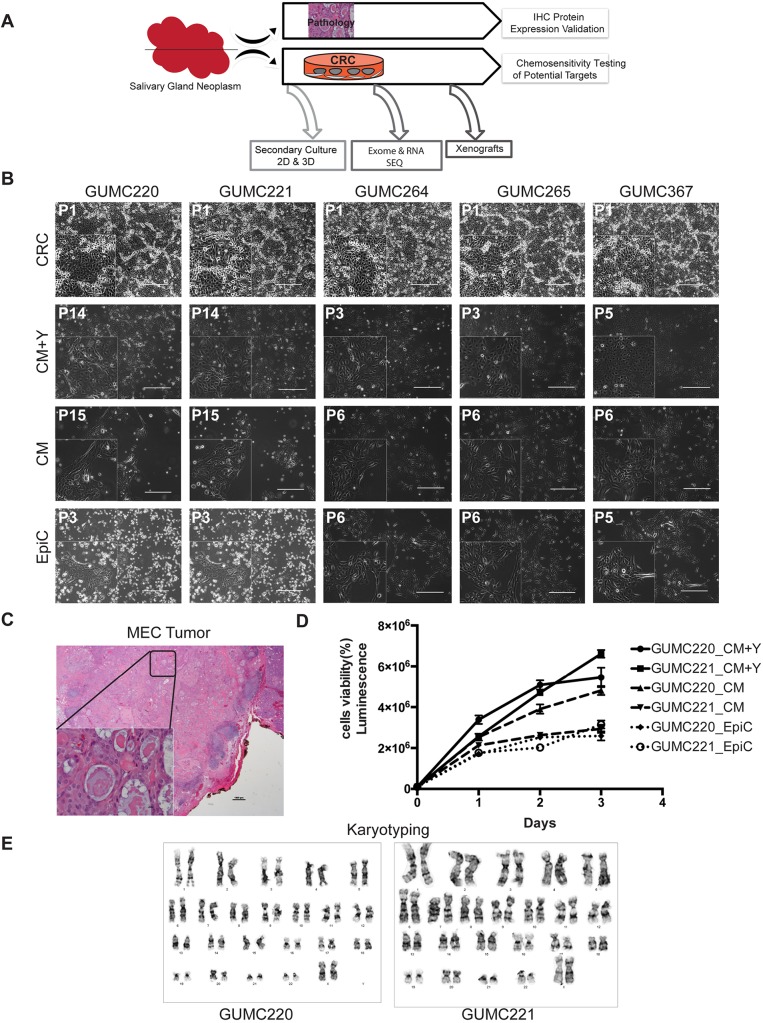
Primary cancer cell cultures established in CRC were secondarily propagated without the presence of ROCK inhibitor or conditioned media. (A) Overall experimental design. (B) Representative phase-contrast images of primary GUMC220/221 derived from a well-differentiated sublingual MEC in CRC, CM+Y, CM and EpiC media. GUMC264/265 and GUMC367 cultures derived from squamous cancers metastatic to parotid gland also grew in all three media. Passage numbers are indicated at the top left. Images were taken at 10× magnification. Scale bars: 400 μm. n=4 culture conditions per sample. GUMC220/221 and GUMC264/265 are biological replicate samples. (C) H&E-stained MEC tumor from which GUMC220 and GUMC221 biological replicate cultures were derived. Image was taken at 10× magnification. Scale bar: 10 μm. The bottom left inset shows a magnified image taken at 40× magnification. Scale bar: 10 μm. (D) GUMC220 and GUMC221 cell viability curves in CM+Y, CM, and EpiC media over 3 days. Each experiment included three cell/condition technical replicates and each experiment was completed three times. Luminescence: CellTiter-Glo® (Promega). Data are mean±s.e.m. (E) Primary CRC-cultured GUMC220 and GUMC221 cells show normal karyotypes (46, XX). CRC, conditionally reprogramming cells; CM+Y, conditioned media+ROCK inhibitor (Y-27632); CM, conditioned media without Y-27632; EpiC, EpiCult™-C Human Medium. Karyotypes shown are representative of n=15 karyotypes evaluated for each.